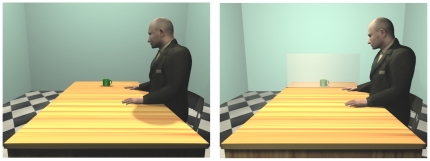
Exemplar go stimuli for Experiment 2.